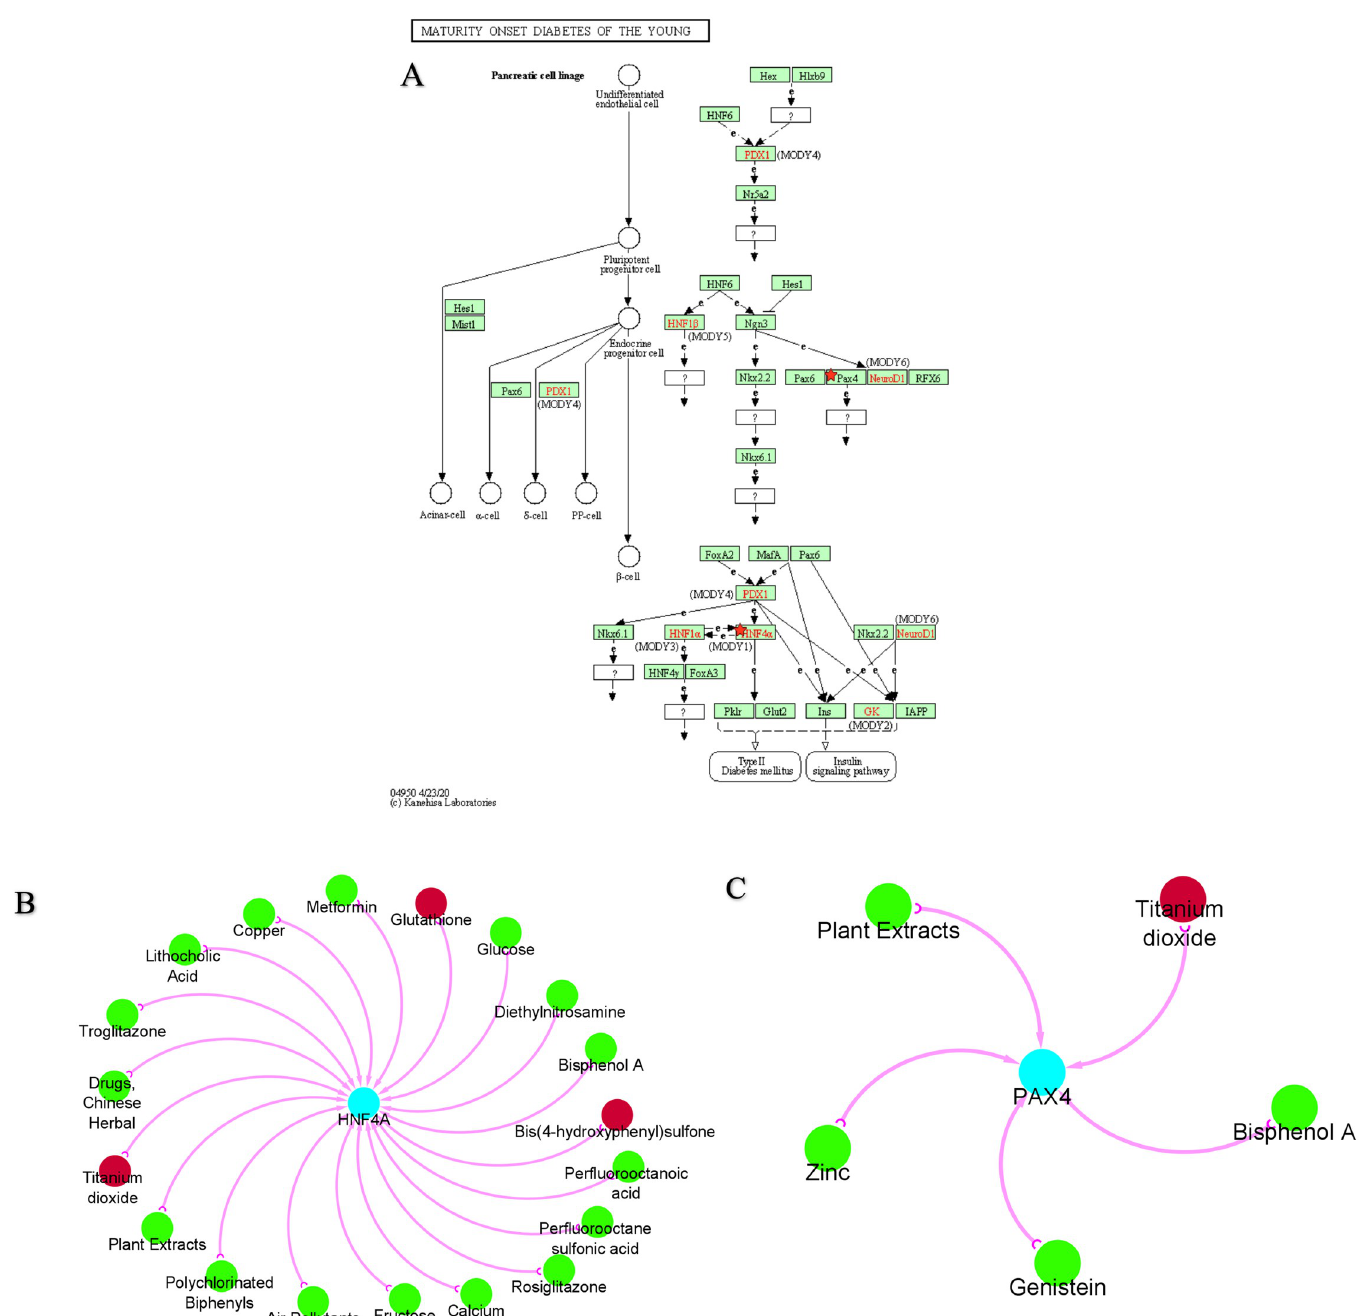
Fig 2. Key genes pathway identification and potential drug design. (A) KEGG pathway enrichment. PAX4 and HNF4A genes were significantly enriched in the maturity onset diabetes of the young. (B and C) HNF4A and PAX4 are each linked to different potential drugs. Green node : the drug decreases the key gene expression; and red node : the drug increases the expression of the key